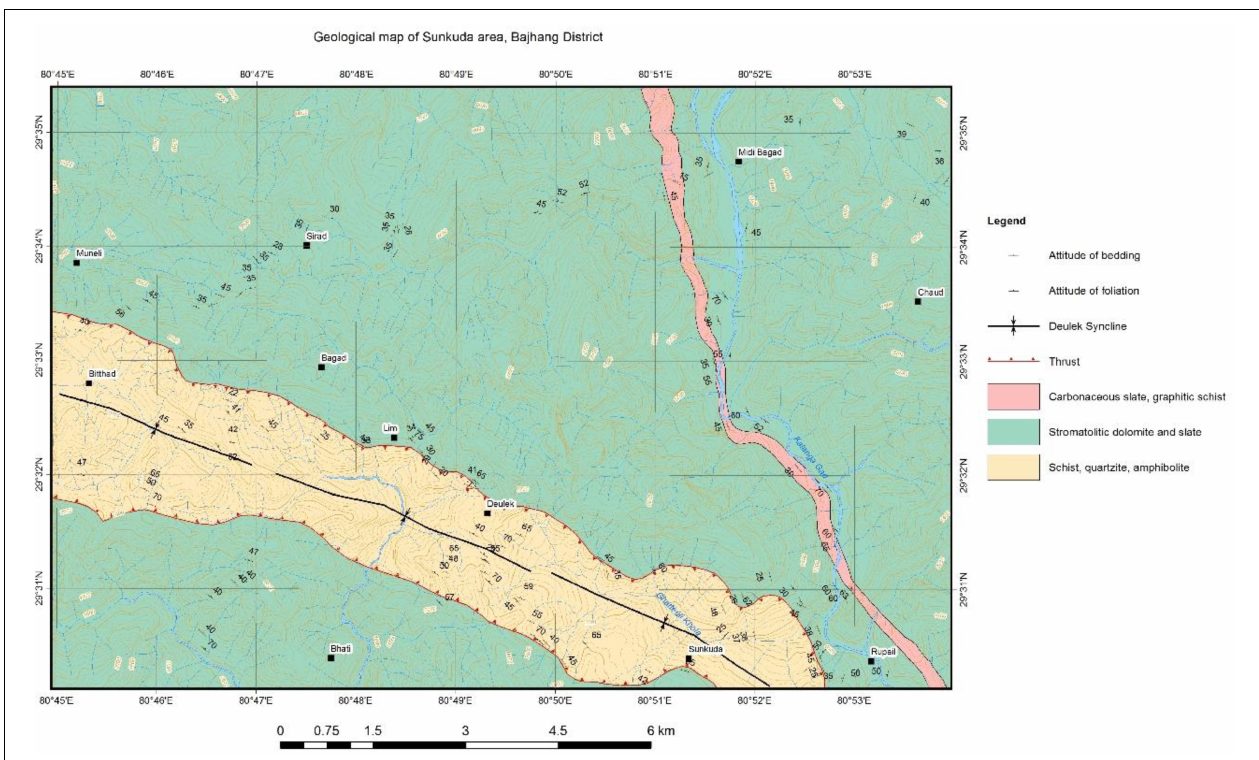
FIGURE 3 | Geological map of Sunkuda and its surrounding region. Source: Field